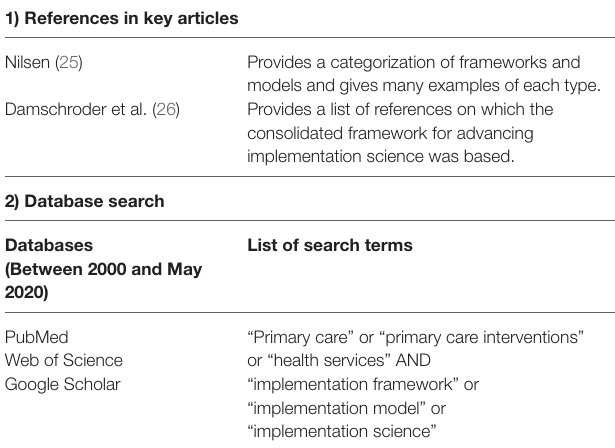
TABLE 1 | Overview of the process of searching